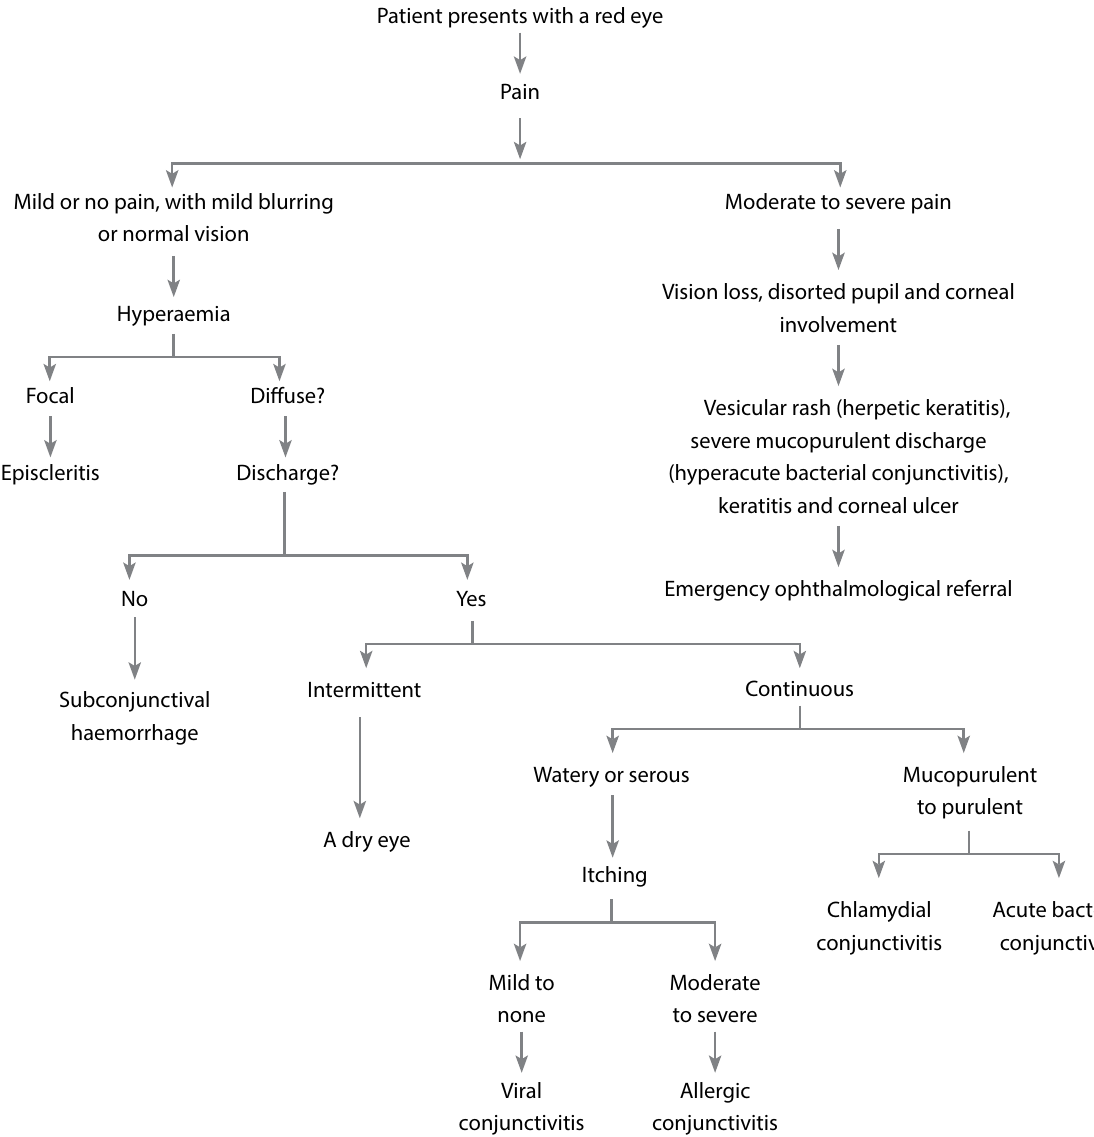
Figure 1: Algorithm to use when diagnosing the cause of a red eye